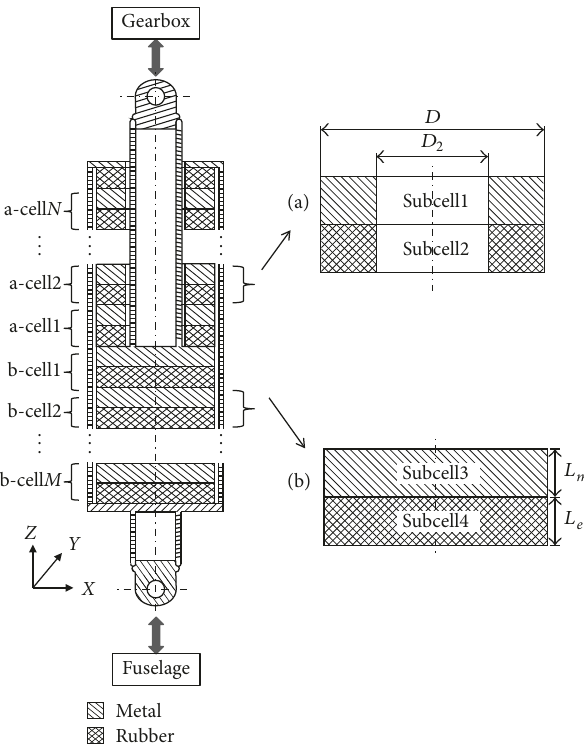
Figure 1: Schematic illustration of a compounded periodic strut for a